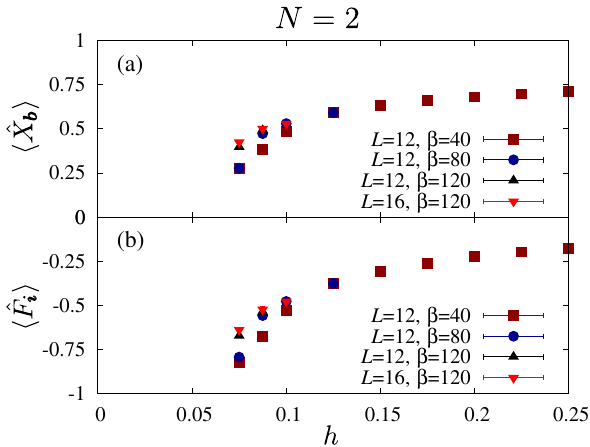
FIG. 10. (a) Electric field and (b) magnetic flux per plaquette as a function of h for the N ¼ 2 model.